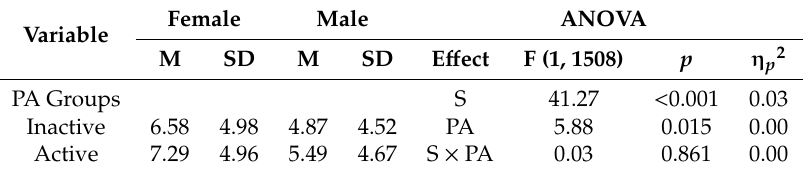
Table 4. Means, standard deviations, and two-way ANOVA statistics for anxiety.